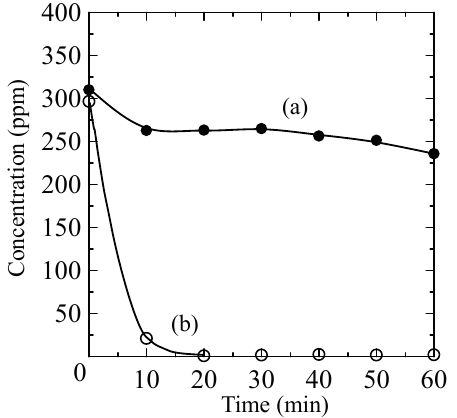
Figure 6. Change in the concentration of 2-propanol due to adsorption by the (a) TiO 2 -coated partially sintered glass and (b) TiO 2 -coated zeolite-porous glass composite.